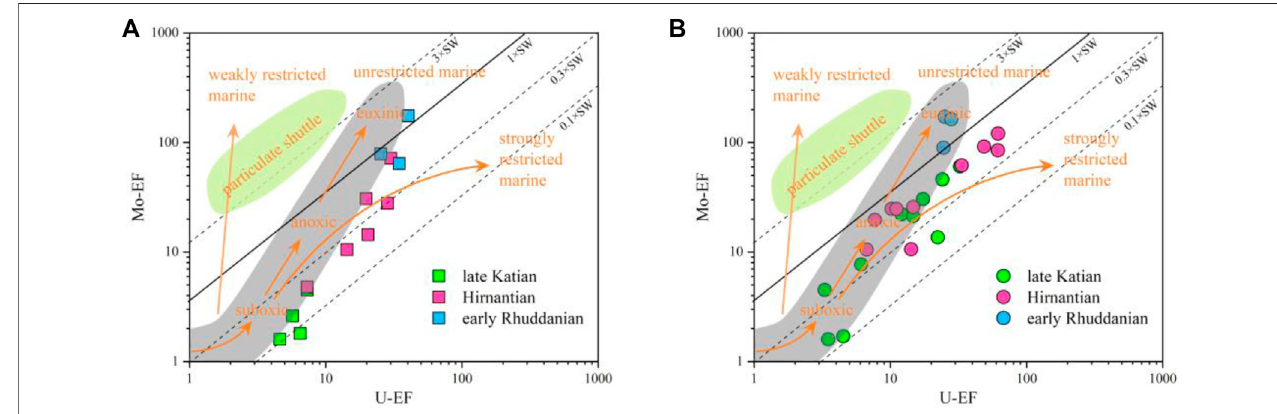
FIGURE7| CovariantrelationshipbetweenU EF andMo EF forthe (A) Changhebiansectionand (B) Tianlinsection.Thesolidlinerepresentsthemolarconcentration ratio of Mo/U in seawater (SW = 7.9).